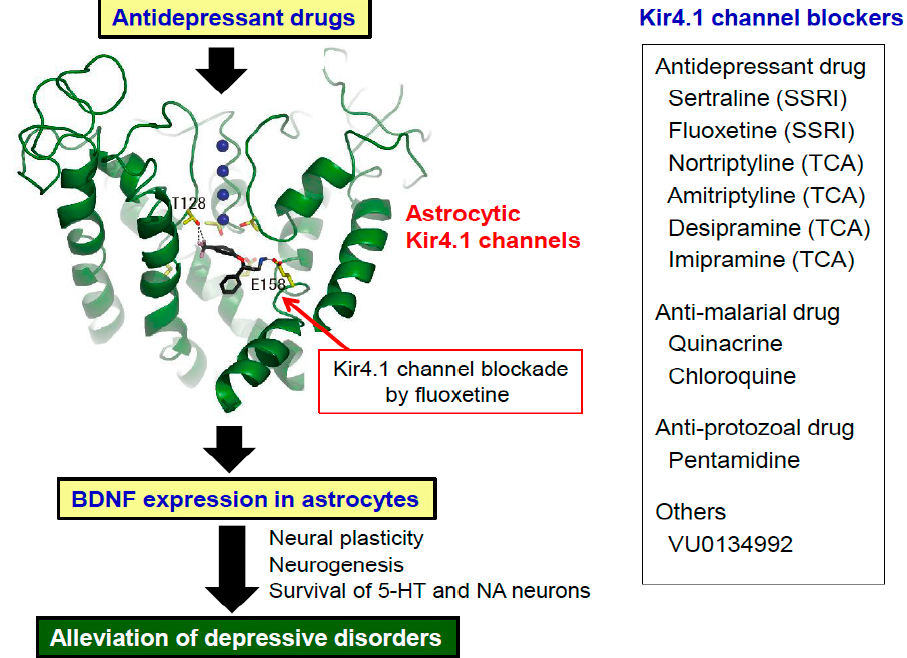
Figure 3. Non-monoaminergic mechanism underlying the antidepressant action of fluoxetine via astrocytic brain-derived neurotrophic factor (BDNF) expression and reported Kir4.1 channel blockers. In silico docking model analysis of Kir4.1 channels with antidepressant drugs revealed that Glu158 can interact with the amine moiety of fluoxetine with an ionic bond and Thr128 with the benzene ring (hydrogen bond acceptor) with a hydrogen bond. The blockade of Kir4.1 channels by fluoxetine facilitate a BDNF mRNA and protein expression in astrocytes, which can potentially alleviate depressive disorders by enhancing neural plasticity, neurogenesis, and survival of 5-HT and noradrenaline (NA) neurons. Kir4.1 channel blockers currently reported are shown in a right side panel. SSRI: Selective serotonin reuptake inhibitor. TCA: Tricyclic antidepressants.